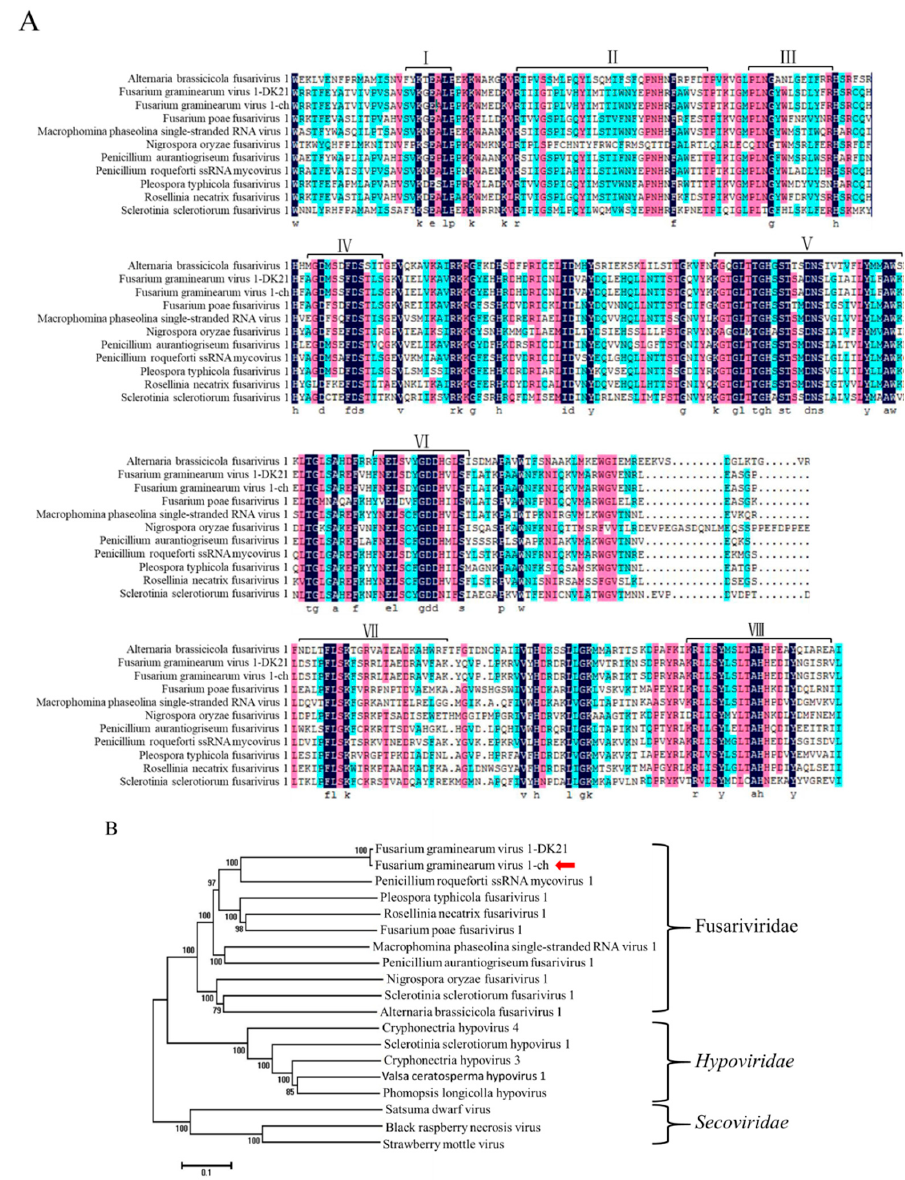
Figure 3. ( A ) Amino acid sequence alignment of FgV1-ch with those of other mycoviruses. Numbers I-VIII indicate the eight conserved motifs in RdRps. ( B ) Phylogenetic analysis of FgV1-ch (marked by arrow) and related RNA viruses. The phylogenetic tree was generated by NJ method in the MEGA 6.0 program. The numbers indicate the percentage of bootstrap replicates that support each branch node (only values > 50% are shown). The scale bar at the lower left represents a genetic distance. The GenBank accession numbers are as follows: Fusarium graminearum virus 1